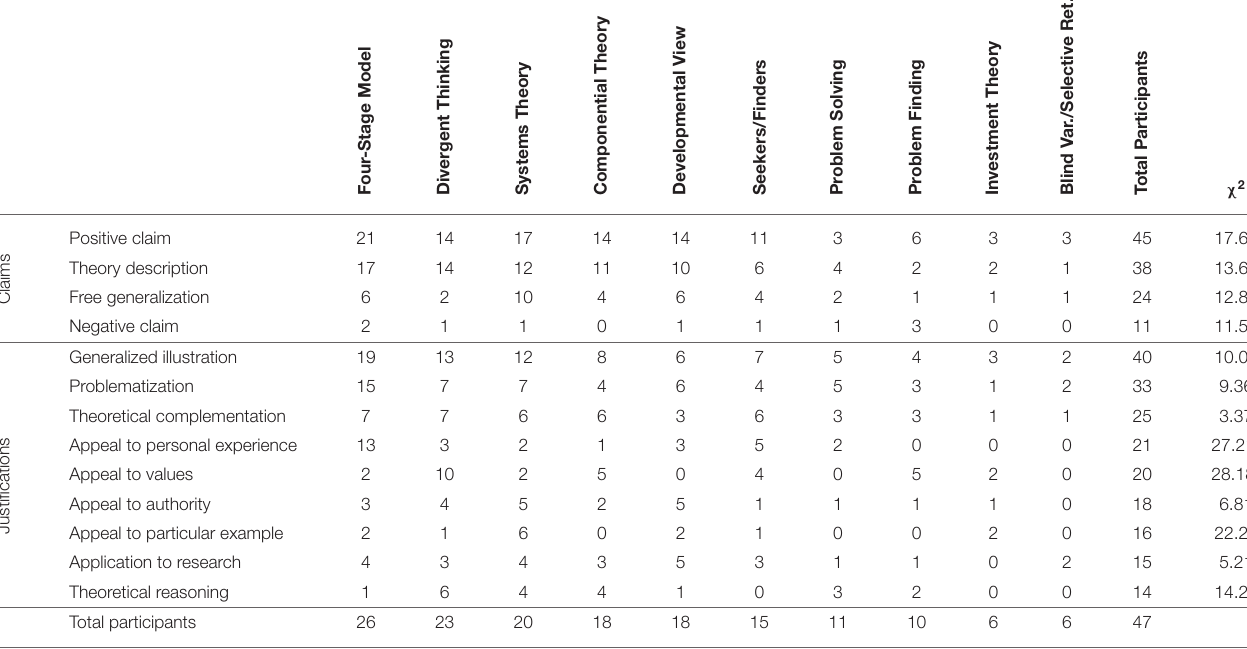
TABLE 4 | The distribution of claims and justifications in the participants’ essays (numbers of participants applying a given argumentative means for discussing a given